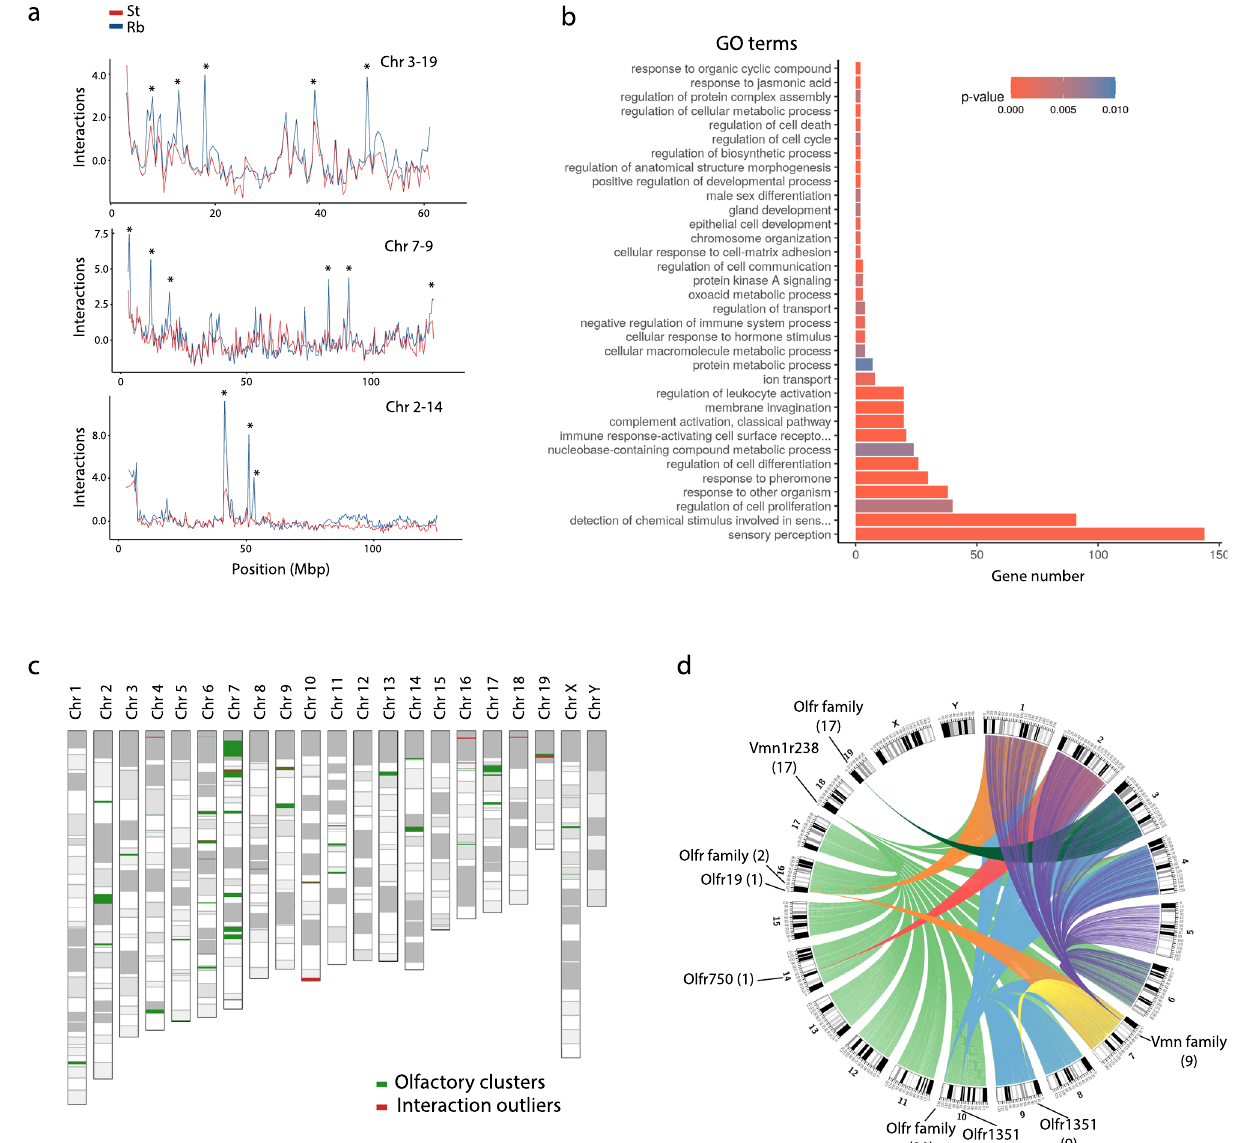
Fig. 6 Interchromosomal interaction and olfactory receptors. a Interaction pro fi les of pairs of chromosomes (3 and 19, 7 and 9, and 2 and 14) in primary spermatocytes (pachynema/diplonema, P/D) of Rb mice. In all three examples, interchromosomal interactions are depicted by asterisks. St standard mice, Rb Rb mice, chr chromosome. Source data are provided as a Source Data fi le. b Gene Ontology Enrichment Analysis (GOEA) of genes in newly detected interchromosomal interactions in pachynema/diplonema of Rb mice. Only signi fi cant gene ontology (GO) terms with an adjusted P value below 0.01 are shown. The X axis represents the number of genes associated to each GO term. Source data are provided as a Source Data fi le. c Mouse ideogram showing the localization of olfactory clusters (green) described in literature 34 , and the interchromosomal interactions detected in this work (red). d Circus plot representing the interchromosomal interactions in the mouse genome related with sensory perception, which are mostly genes from the olfactory (Olfr) and vomeronasal (Vmn) receptor family. The number of genes found in each region and the gene family are shown in parenthesis. Source data are provided as a Source Data fi